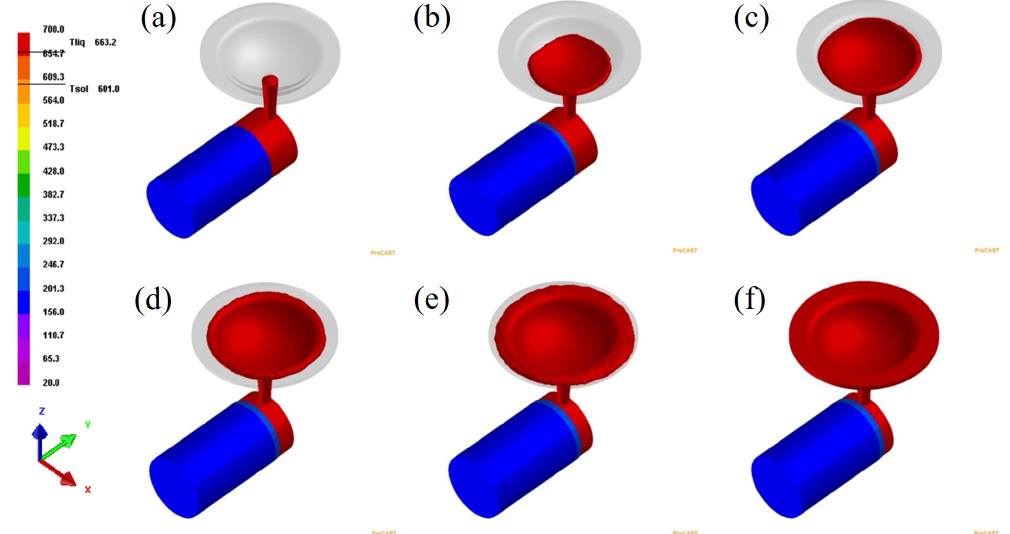
Figure 4. Temperature cloud diagrams for different filling rates when the punch movement rate was 0.1 m/s: ( a ) 0%; ( b ) 20%; ( c ) 40%; ( d ) 60%; ( e ) 80%; ( f ) 100%.